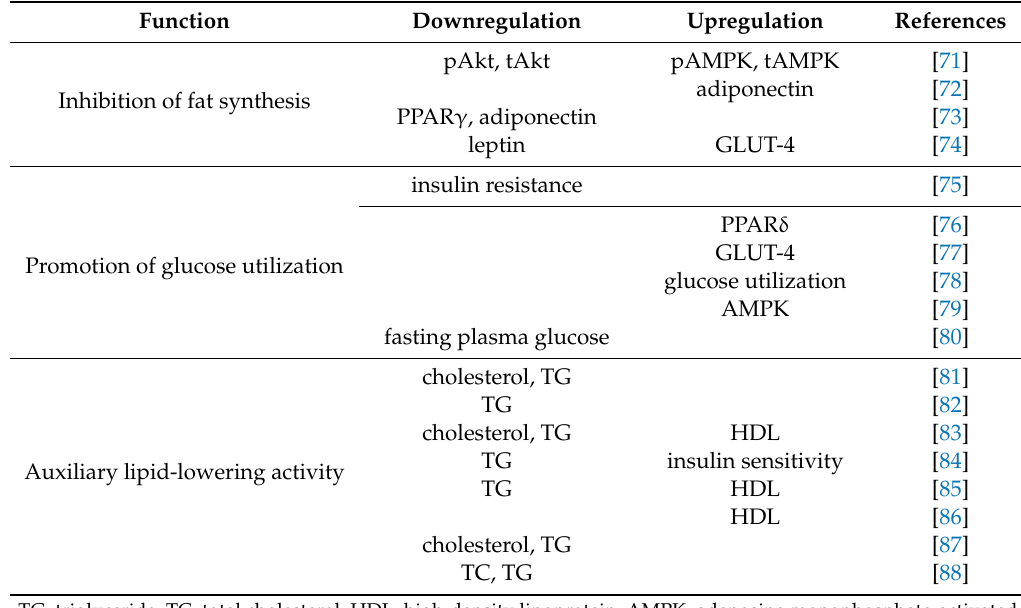
Auxiliary lipid-lowering